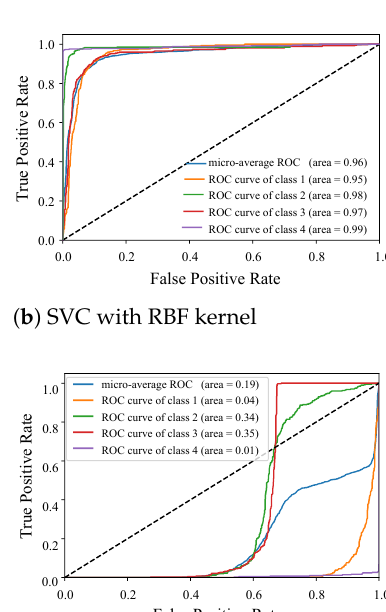
ROC curve of class 3 (area = 0.56) ROC curve of class 4 (area = 0.99)